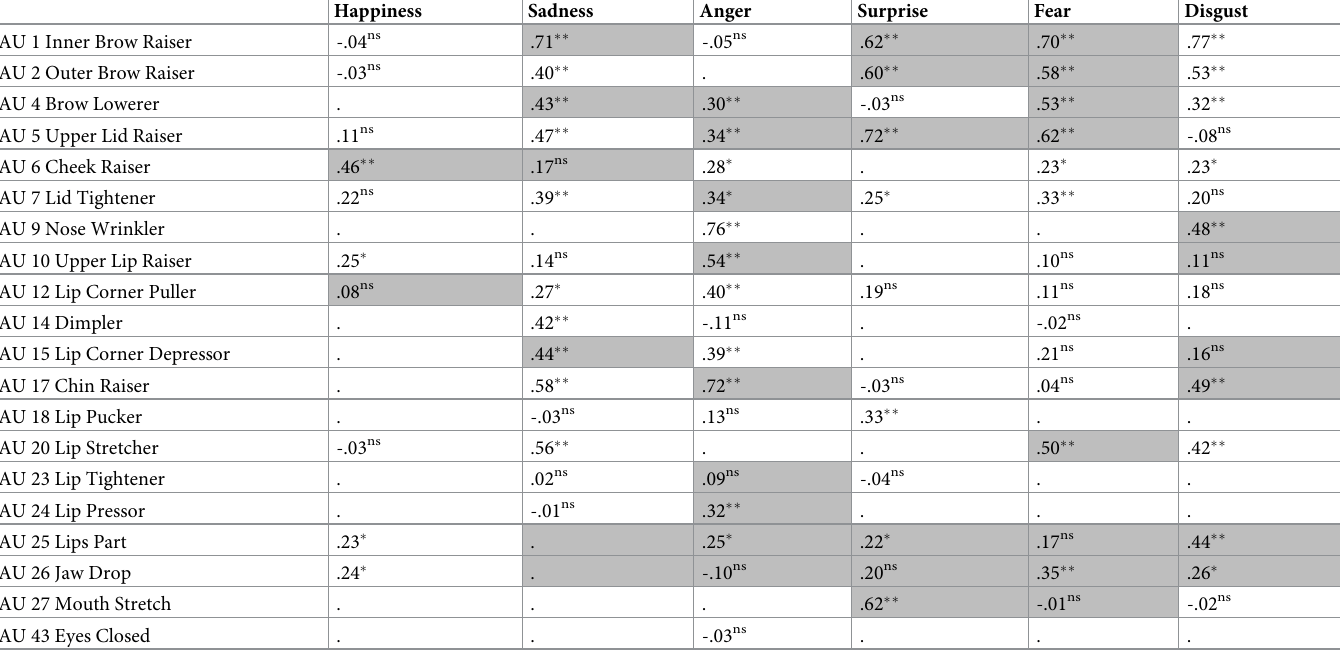
Table 2. Spearman correlations between the coding of action units (AUs) with the Facial Action Coding System (FACS) and automated FaceReader 7 (FR) coding for all emotion expression conditions. Happiness Sadness Anger Surprise